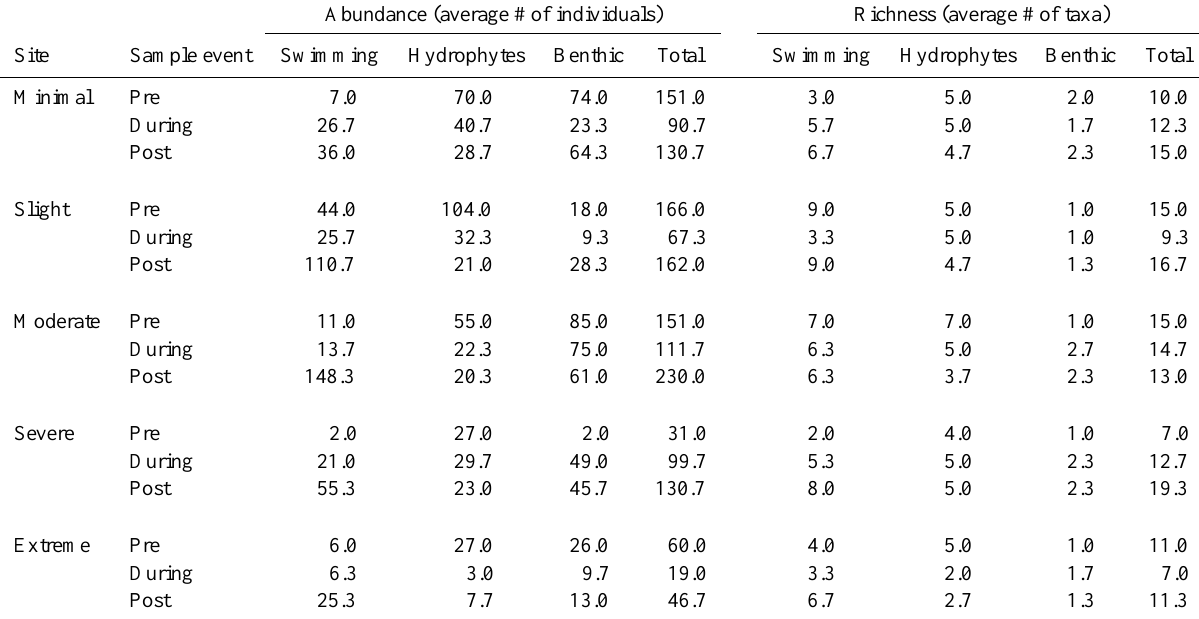
Table 6. Macroinvertebrate abundance and richness at the 5 dewatered sites, grouped by habit pre-, during-, and